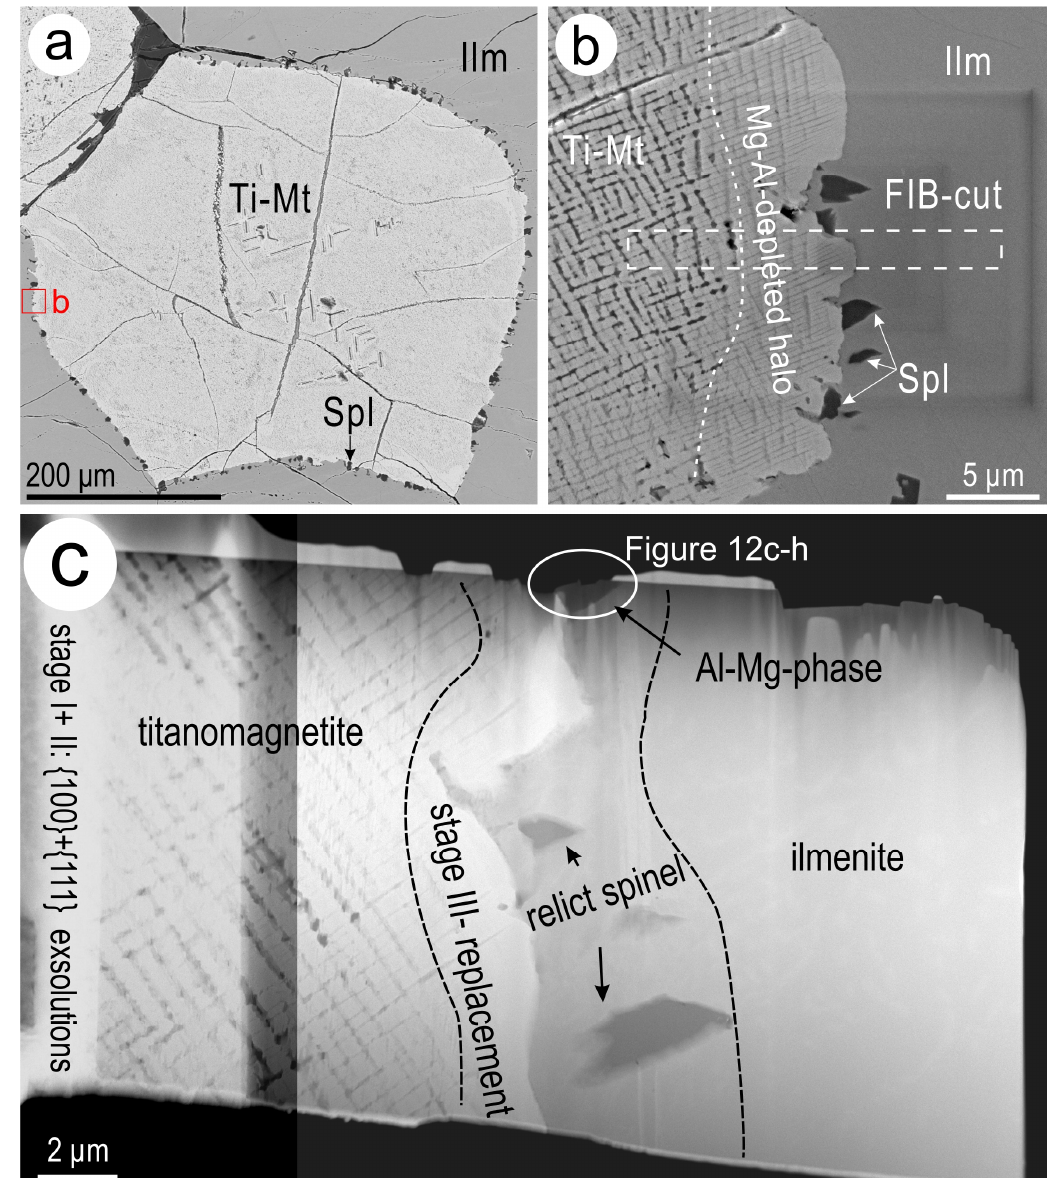
Figure 4. BSE images ( a , b ) and HAADF STEM image ( c ) showing a titanomagnetite (Ti-Mt) grain enclosed within ilmenite (Ilm) that was studied at the nanoscale. ( a ) The titanomagnetite displays a sub-rounded, partially scalloped morphology and contains areas of coarser inclusions, as well as intra-grain fractures. ( b ) Detail of titanomagnetite margin showing inliers of ilmenite replacement. The grain displays weave-patterns of inclusions that appear to fade away towards the contact boundary with ilmenite. The contact is also marked by irregular grains of spinel (Spl). ( c ) In-depth, the titanomagnetite shows comparable features with those described on the surface of the polished block. The only difference is that the weave pattern of inclusions becomes an apparent {100} network.